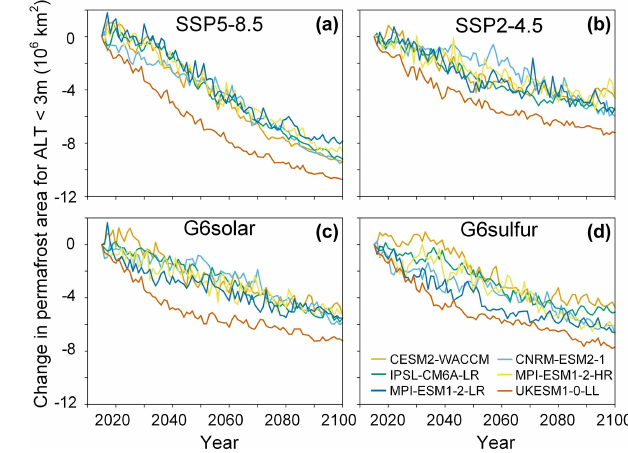
Figure 4. Cumulative change in circum-Arctic permafrost area de- rived from bias-corrected TSL. Simulations are performed under the (a) SSP5-8.5, (b) SSP2-4.5, (c) G6solar, and (d) G6sulfur scenarios up to the year